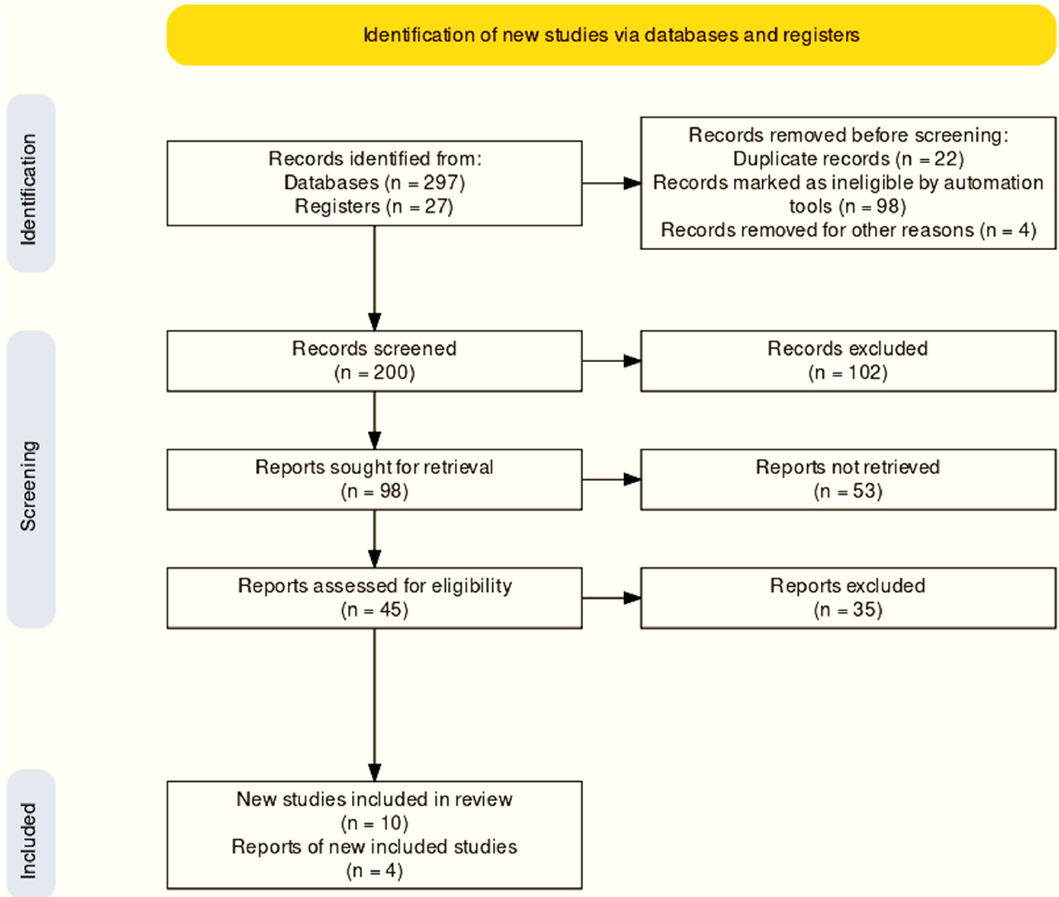
Figure 4. PRISMA flowchart.